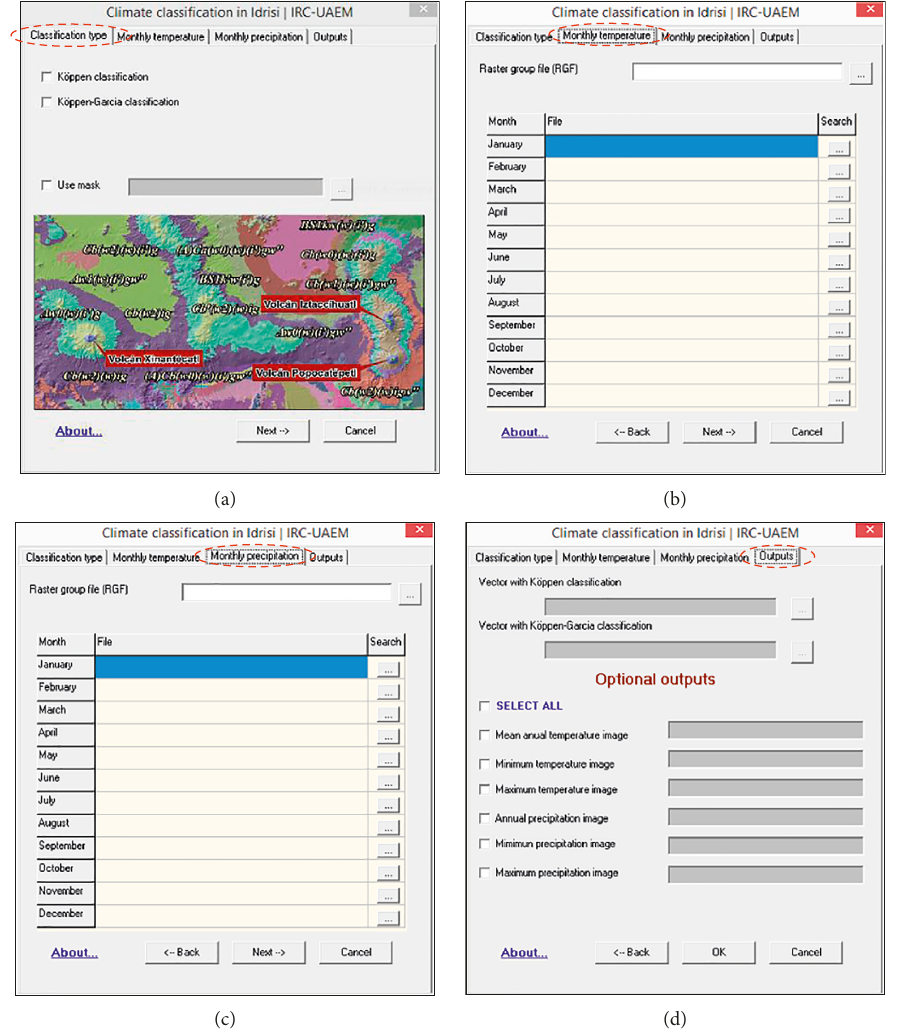
Figure 3: Windows for the module automating the K¨oppen–Garcia climate classification